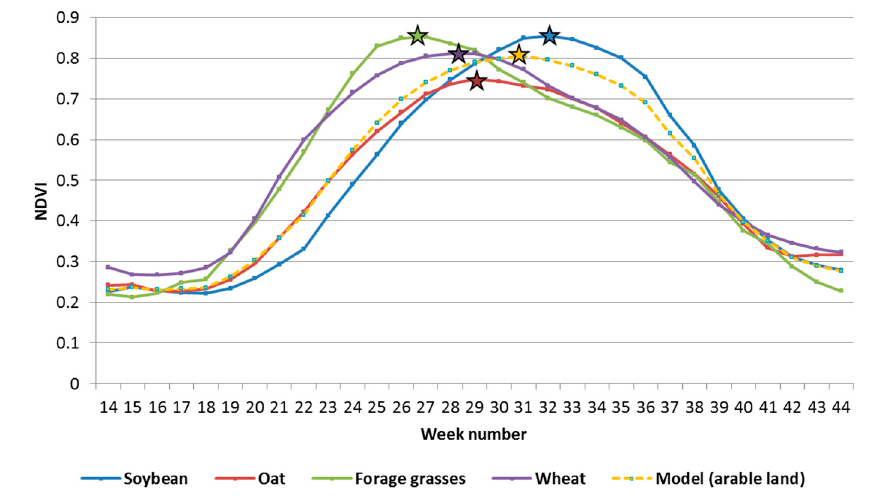
Figure 5. The NDVI seasonal variation curves for crops grown in the experimental fields in 2018 (the maximum NDVI values are marked with stars).